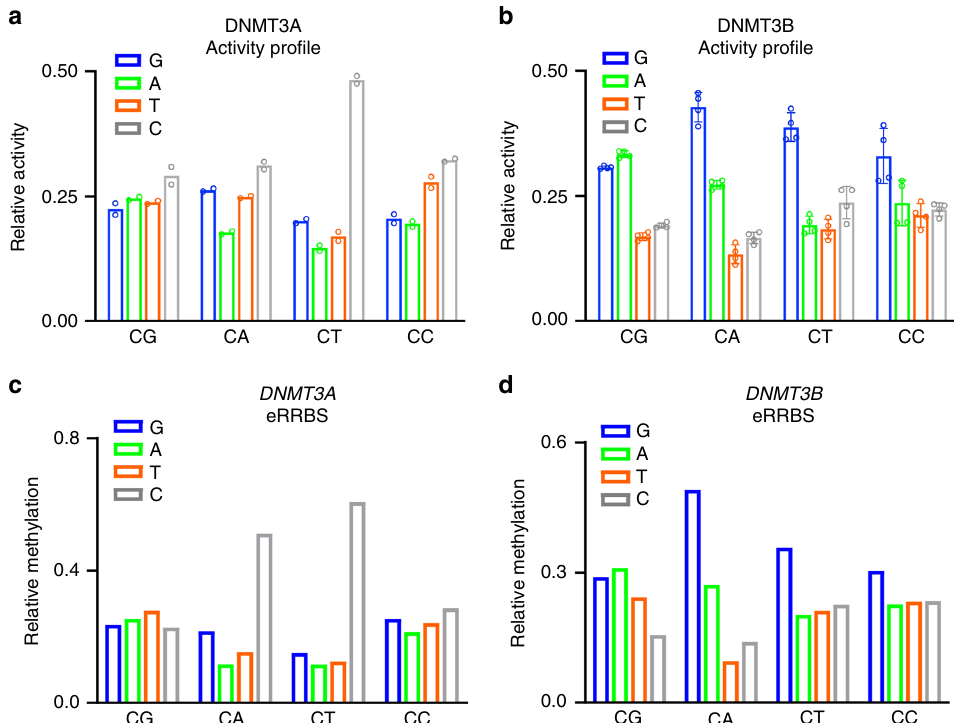
Fig. 2 Non-CpG methylation by DNMT3A and DNMT3B. a , b CpG and non-CpG methylation of mDNMT3A a and mDNMT3B b averaged for the different + 1 fl anking base pairs. The cytosine-containing dinucleotides are displayed on the horizontal axis and + 1 base is shown in the different bars, respectively. Data are mean of two replicates a or mean ± SD of 4 replicates b . c , d eRRBS analysis of CpG and non-CpG methylation in TKO cells introduced by hDNMT3A c and hDNMT3B d averaged for the different + 1 fl anking base pairs (depth of reads >10). The cytosine-containing dinucleotides are displayed on the horizontal axis and + 1 base is shown in the different bars. Source data are provided as a Source Data fi